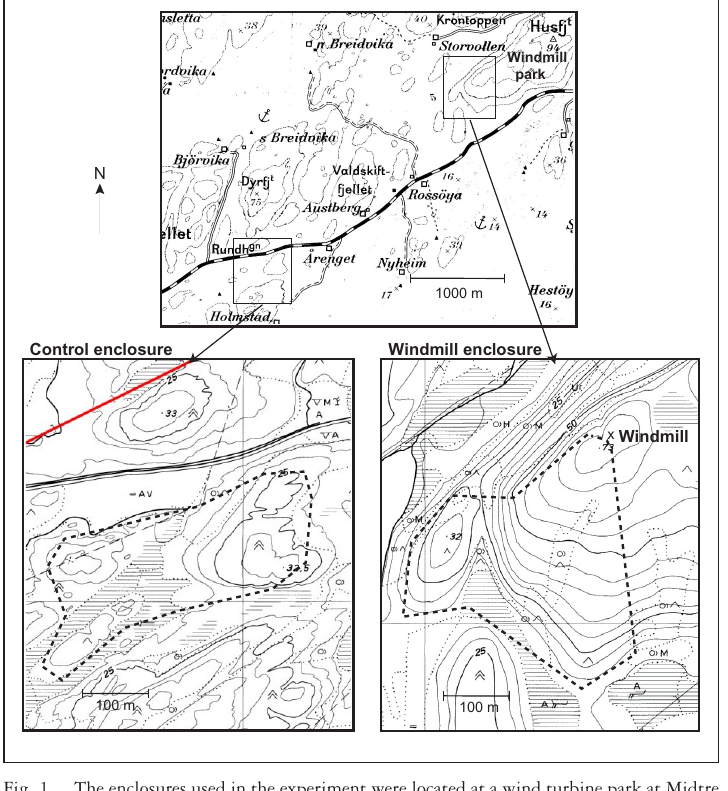
Fig. 1. The enclosures used in the experiment were located at a wind turbine park at Midtre Vikna (lat 64°52’N, long 10°57’E) in North-Trøndelag County, Mid-Norway. (Permission no. Ugland IT